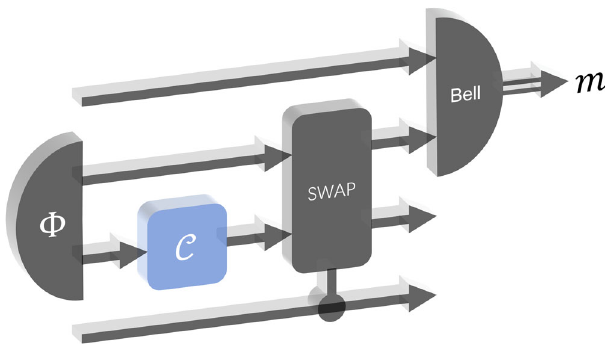
Fig. 3 Probabilistic realisation of the quantum time fl ip. An unknown channel C is applied locally on a maximally entangled state Φ , which then undergoes a controlled SWAP operation and is used as a resource for quantum teleportation. The probabilistic realisation of the quantum time fl ip is heralded by a speci fi c value of the outcome m of the Bell measurement in the teleportation